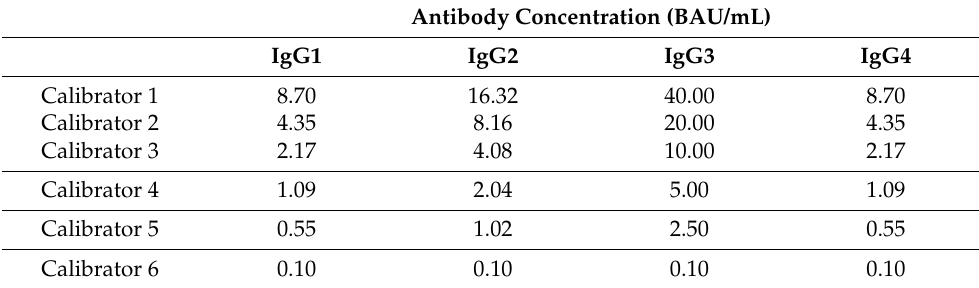
Table 3. Calibrator values for each anti-N protein antibody subclass.